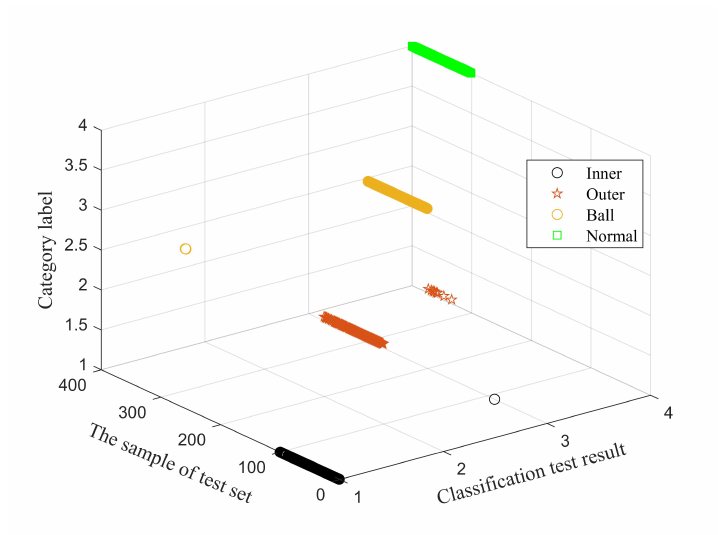
Figure 16. Classification accuracy test results of the DBN model without signal cleaning.